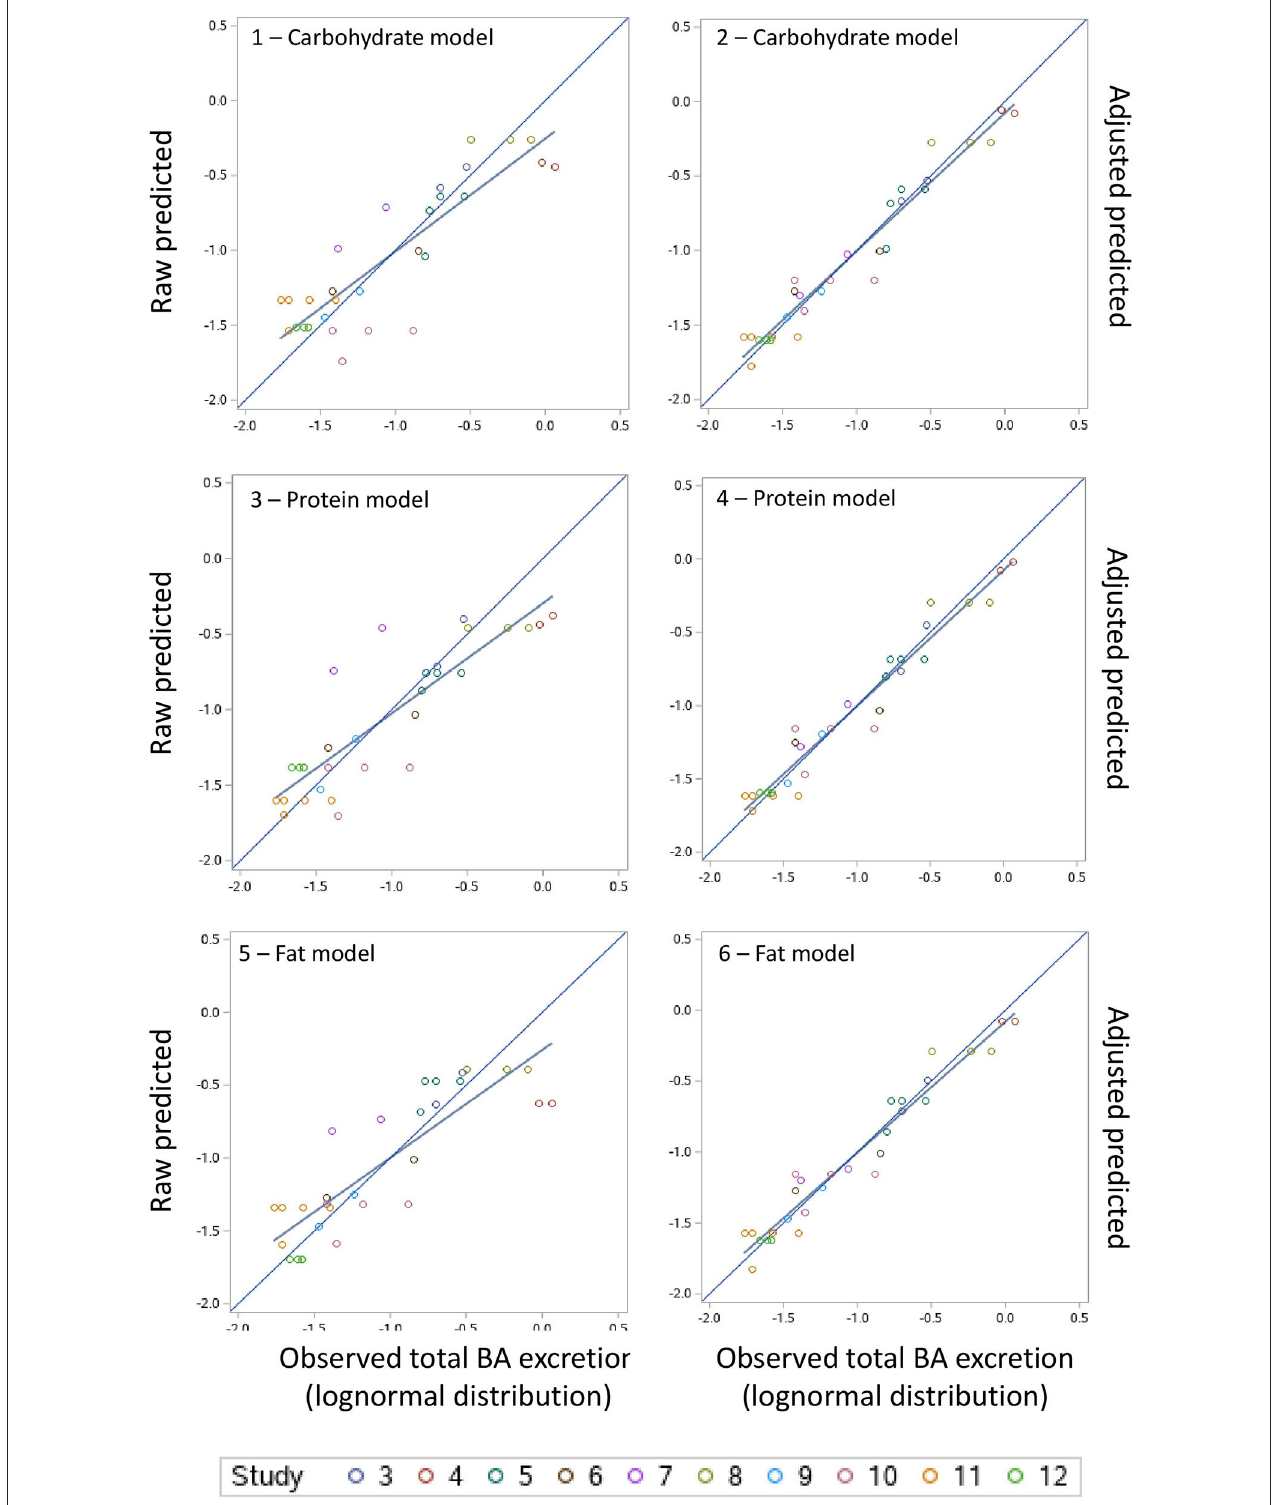
FIGURE 3 | Raw predicted vs. observed and adjusted-predicted vs. observed plots for the carbohydrate, protein and fat models.